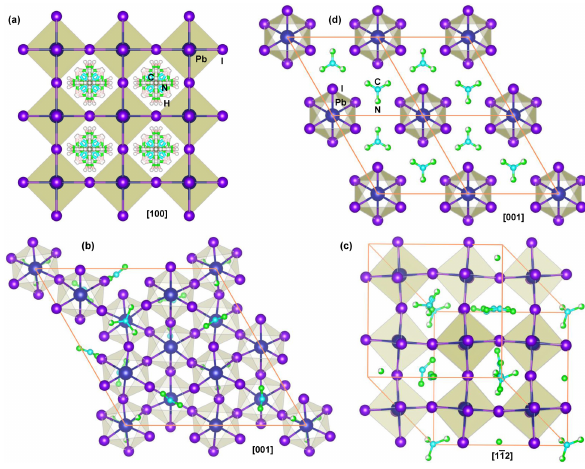
Figure 16: Structural models of (a) α -HC(NH 2 ) 2 PbI 3 along [100], β - HC(NH 2 ) 2 PbI 3 along (b) [001] and (c) [1 1 2], and (d) δ -HC(NH 2 ) 2 PbI 3 along [001].